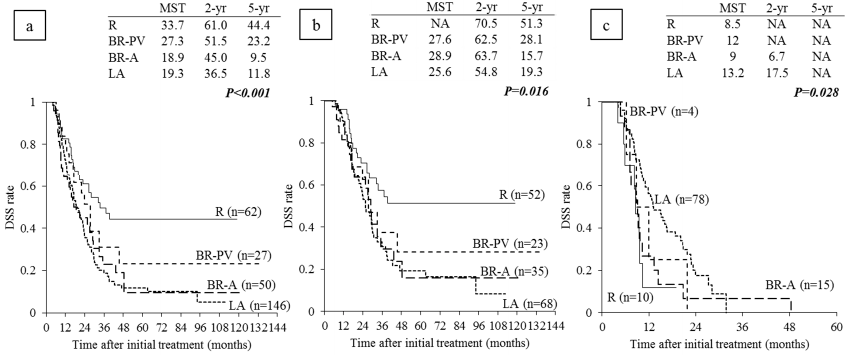
Figure 3. Disease-specific survival (DSS) curves according to the anatomical resectability classification. ( a ) All patients who completed CRT and underwent re-evaluation after CRT (n = 285); resection * (n = 178); ( c ) Patients without resection (n = 107). * Including four patients with distant metastasis at re-evaluation (two in R and two in BR-A) and six patients with intraabdominal distant metastasis at laparotomy (one in R, one in BR-PV and four in LA). R: resectable, PDAC: pancreatic ductal adenocarcinoma, BR-PV: borderline resectable (superior mesenteric vein/portal vein invasion alone), BR-A: borderline resectable (arterial invasion), LA: locally advanced, MST: median survival time (months), NA: not